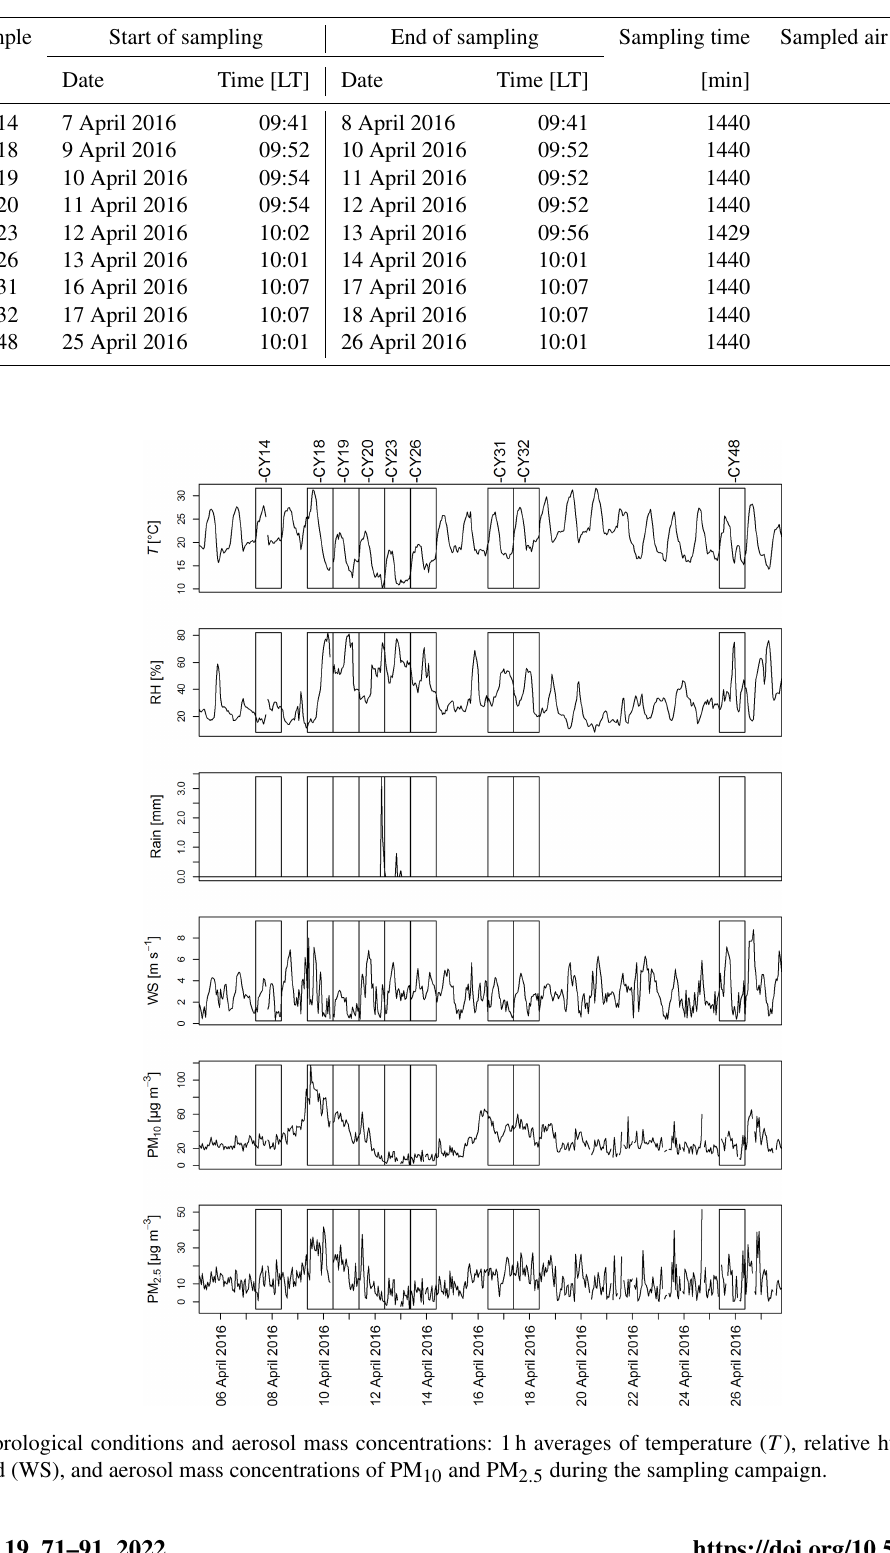
Table A1. Overview of air filter samples. Sample names, sampling periods, and sampled air volumes at standard conditions (0 ◦ C, 1013hPa).